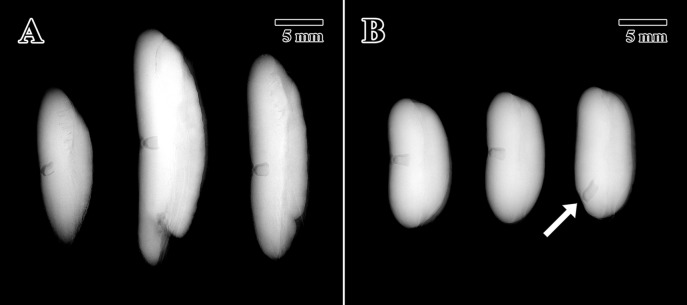
X-ray tomogram of experimental seed lots. (A) 1873 EBC seed lot sample. (B) 2004 MSB seed lot sample. (Arrow = embryo location at distal portion of the endosperm). Scale bar = 5 mm.